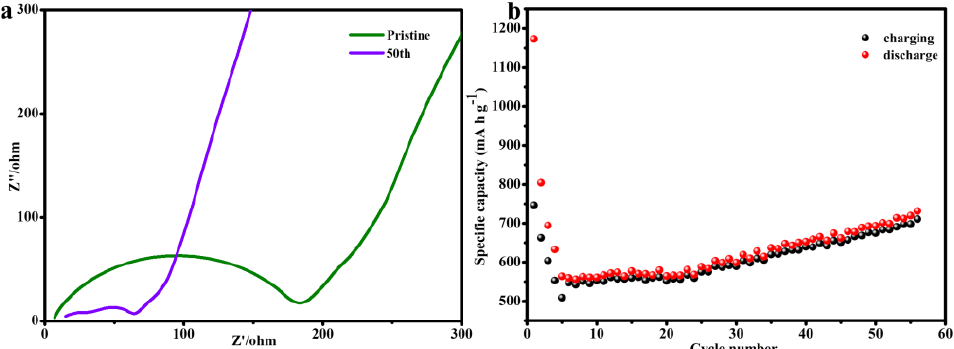
Figure 7. ( a ) Electrochemical impedance spectroscopy (amplitude: 5 mV, 100 kHz–0.01 Hz). ( b ) Cycle performance of GO/B-AsP/CNTs at 0.1 A g −1 for 50 cycles.